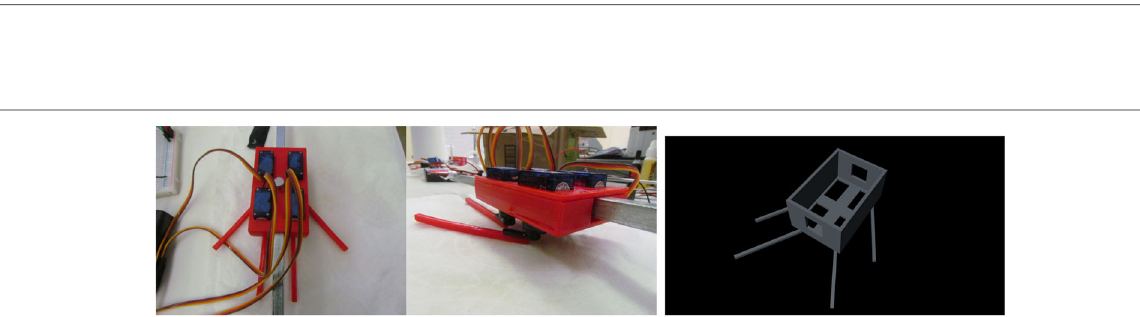
Fig. 23 Comparaison between the abnormal periodic strokes and the experimentally observed stroke. The top figures display the variation of the appendage angles with respect to time. The observed ones reflect the constraint on the angles. The bottom figures show the strokes as closed curves in the triangular prism